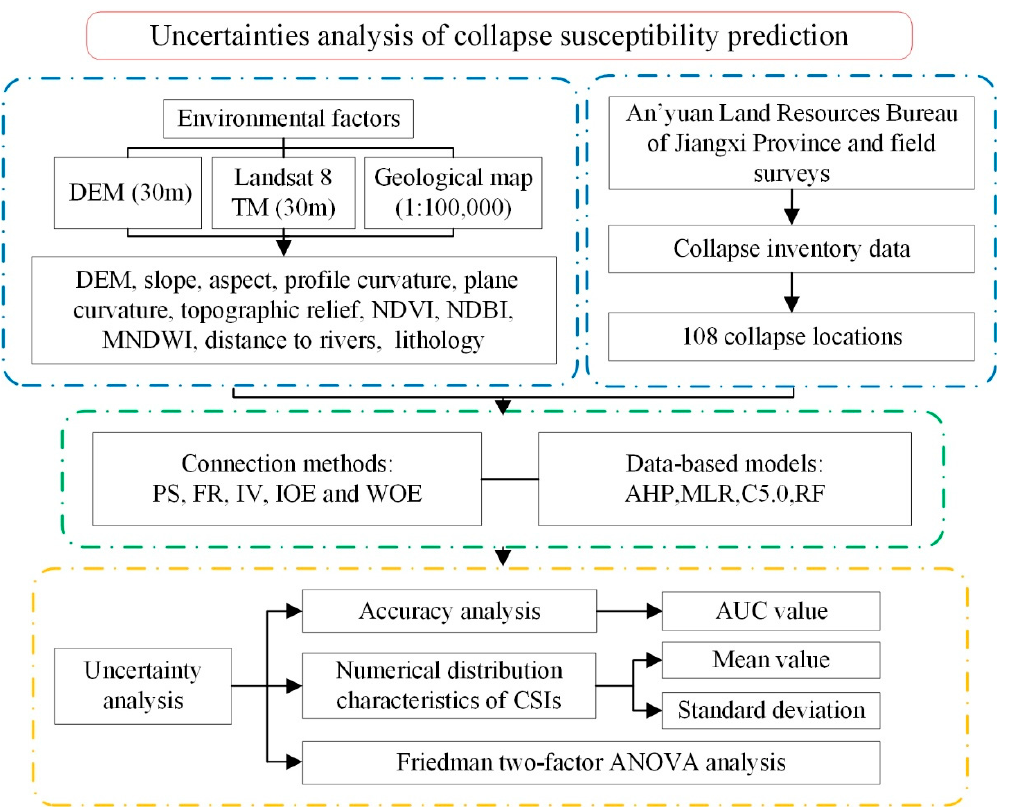
Figure 3. The flowchart used in this research.